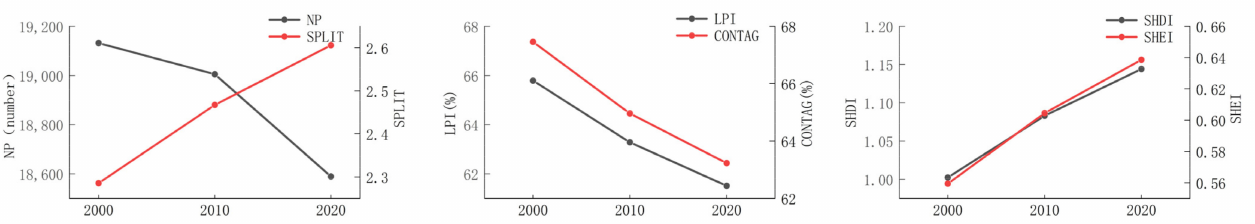
Figure 7. Landscape Level Index of Chaohu Lake Basin in 2000, 2010, and